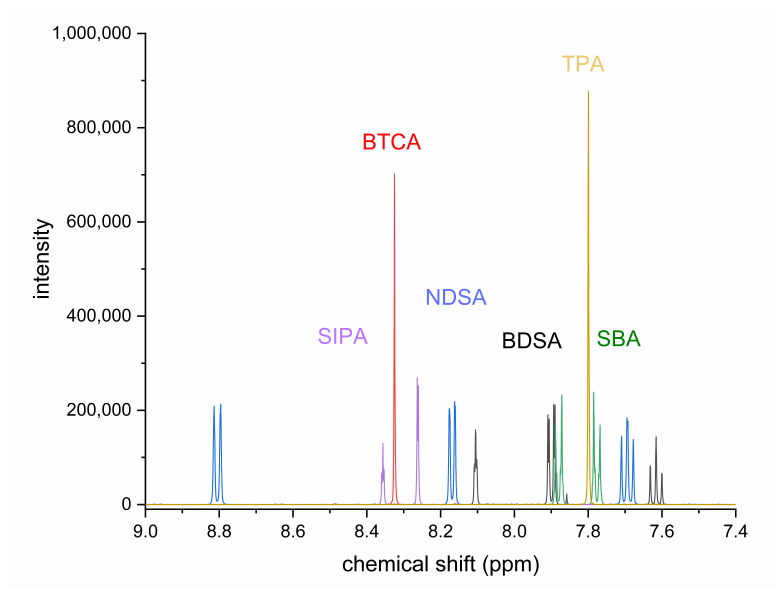
Figure 5. Aromatic proton signals for the selected standard candidates at pH 12 (for abbreviations, see Figure 4). BDSA and NDSA signals may overlap with amino acid signals that reach up to 7.65 ppm and, therefore, are less useful for this application. The concentrations were around 1 g/L in deuterated phosphate buffer (100 mM, pH 12); 500 MHz spectrometer frequency, 16 scans, 5 s relaxation delay, 30 ◦ observation pulse, and no